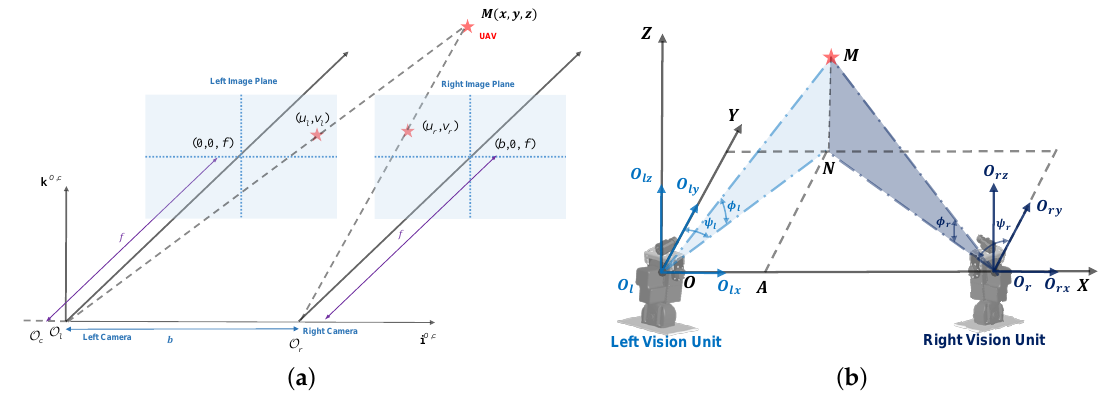
Figure 4. ( a ) Theoretical stereo vision model; ( b ) theoretical optical model. The target M is projected at the center of the optical